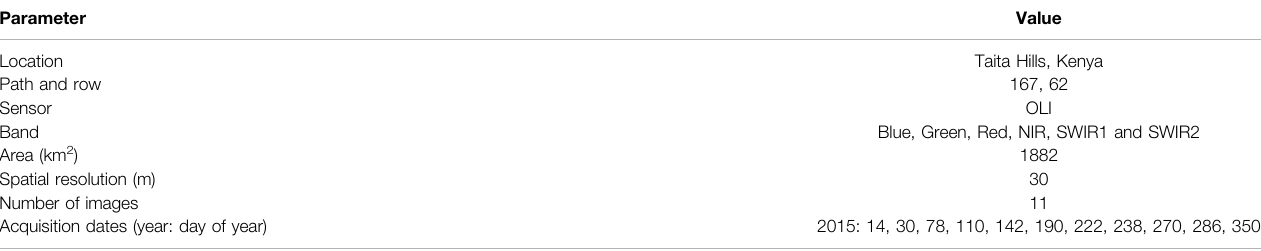
TABLE 1 | Characteristics of Landsat 8 Operational Land Imager (OLI) images. Parameter